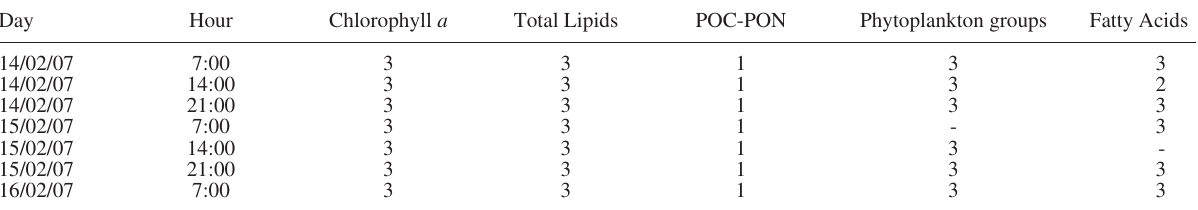
Table 1. – Sampled variables and number of replicates made each time in the fixed point from 7:00 on 14 February 2007 to 7:00 on 16 February